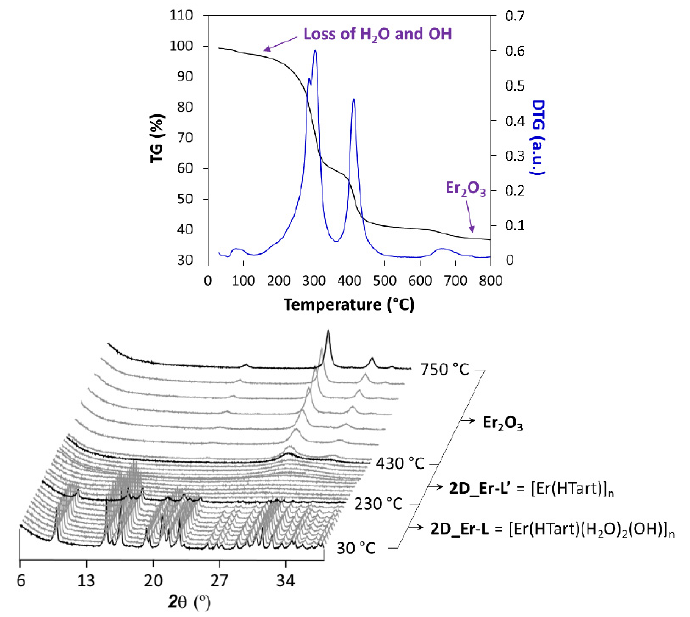
Figure 4. Analysis of the thermal behavior of compound 2D_Er-L . Note: diffractograms shown in black correspond to temperatures at which phase transition takes place.